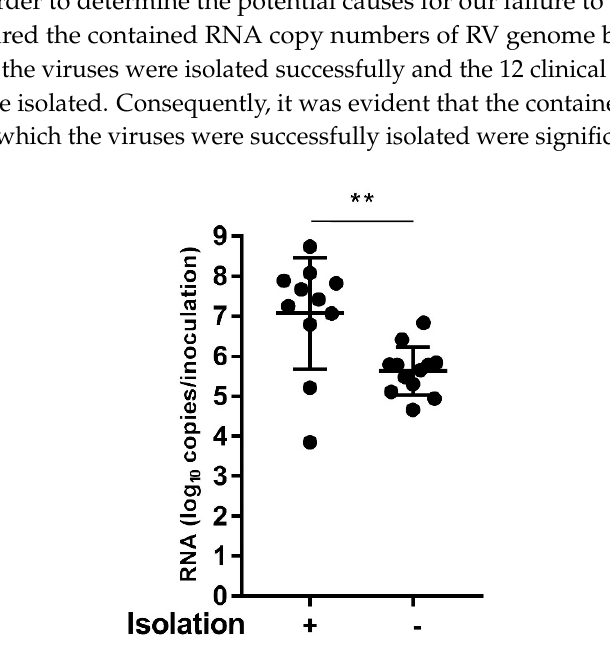
Figure 4. Comparison of RNA copy numbers of RV genomes between the 11 clinical specimens from which the viruses were successfully isolated and the 12 clinical specimens from which the viruses could not be isolated. Differences were analyzed by Welch's unpaired t test. ** p < 0.01.